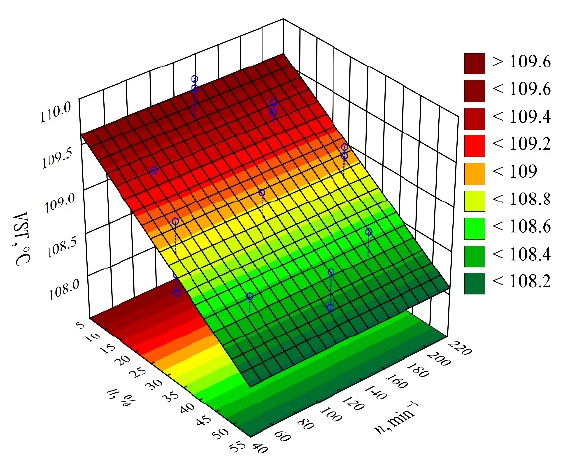
Figure 14. Pareto plots of the standardized effects of empirical full model Vicat softening temperature VST, the vertical line in the plot corresponds to the arbitrarily chosen level of significance ( p = 0.05).